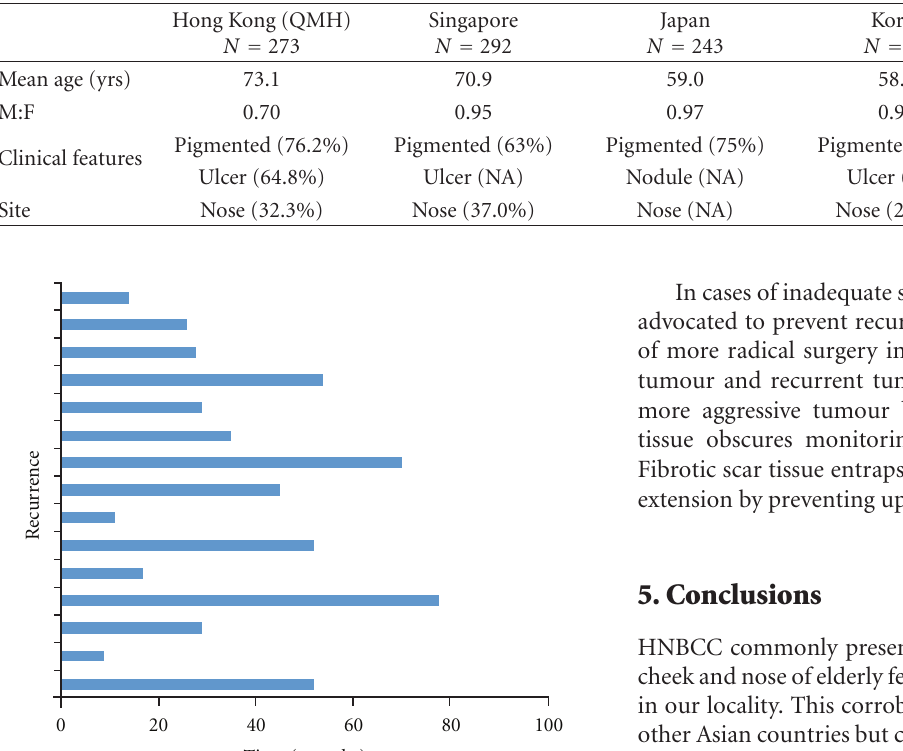
Figure 6: Treatment outcomes of patients who chose to undergo further treatment versus observation in those with inadequate margins. Table 1: A table comparing our results with other Asian and Caucasian populations.